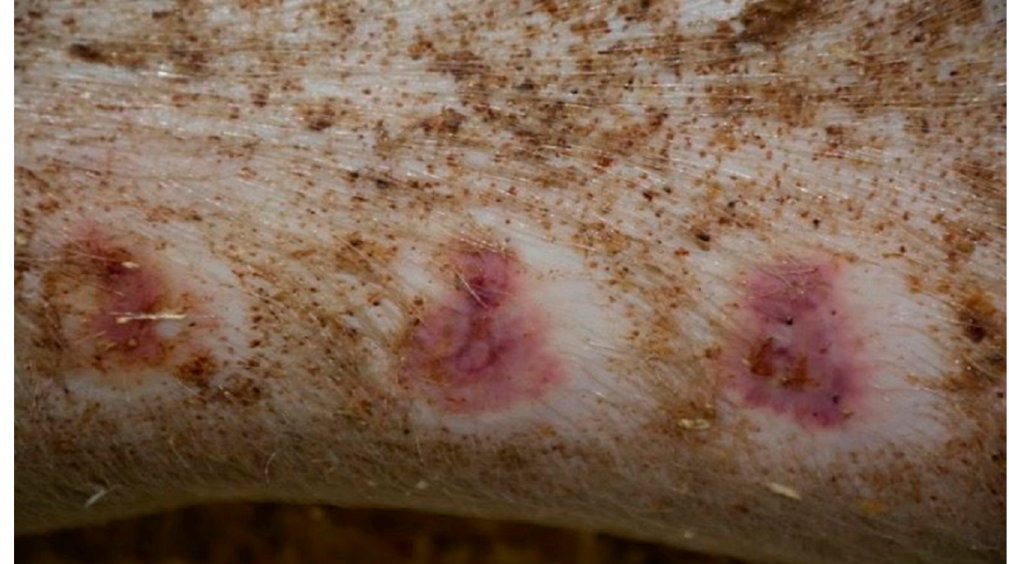
Figure 9. Group D1—burn wound treated with the 1% propolis ointment on day 25.